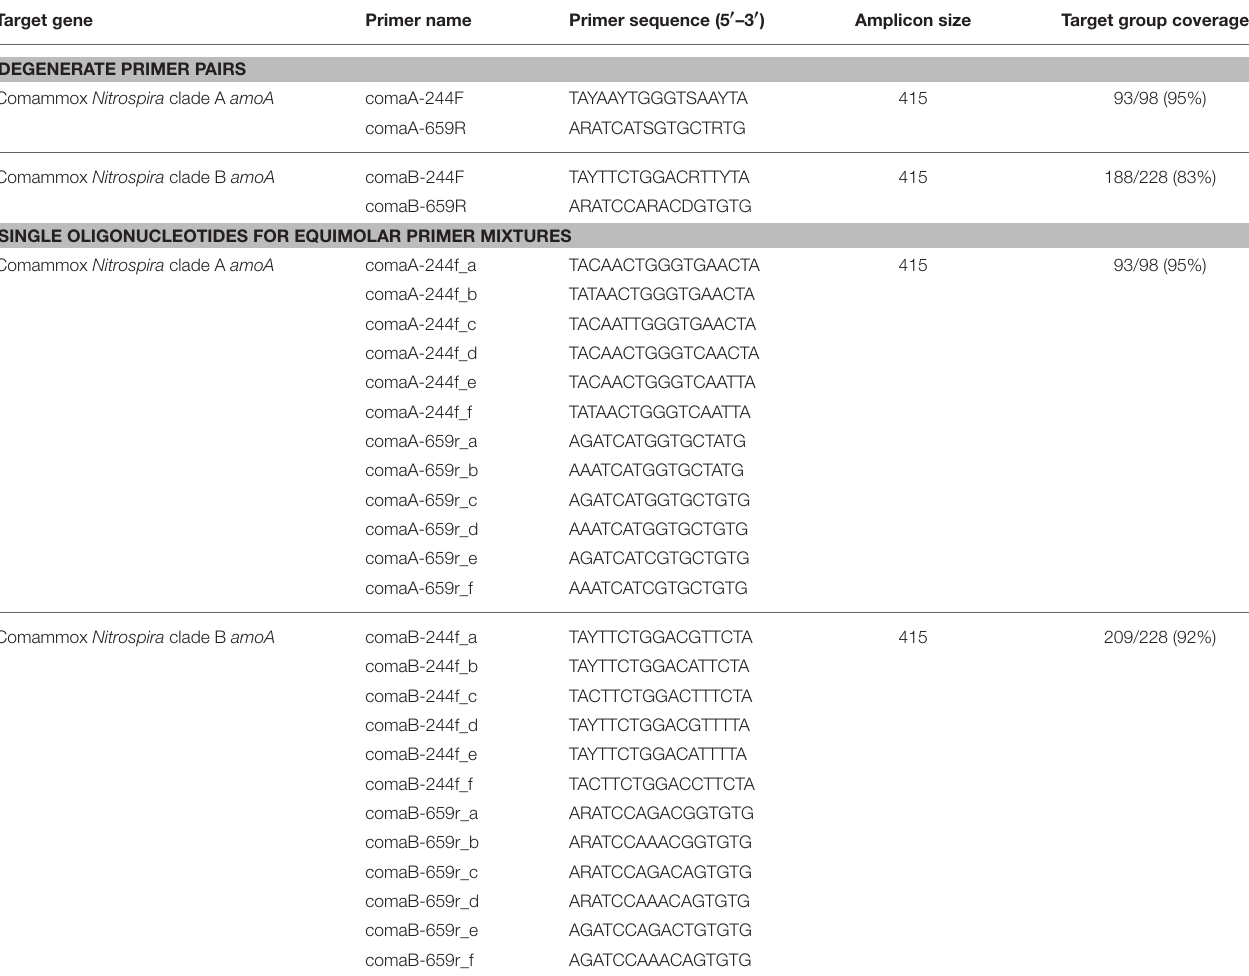
TABLE 1 | Comammox amoA -targeted primers designed in this study, and in silico evaluation of the primer coverage of the target clades in our comammox amoA reference sequence